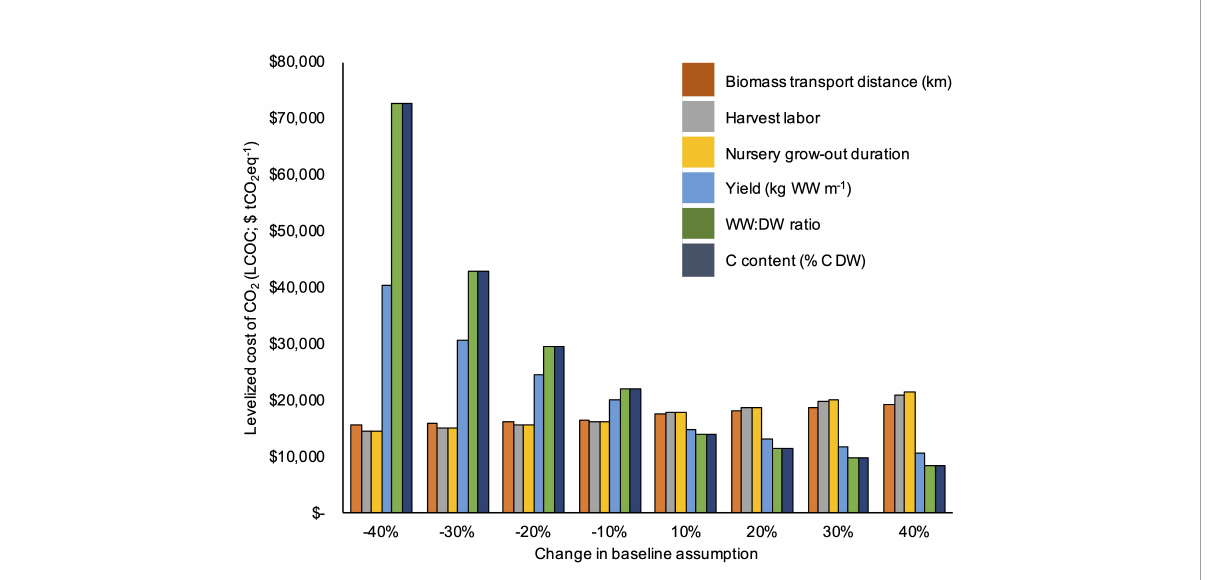
FIGURE 6 Results of a sensitivity analysis in which the required biomass transport distance (km), harvest labor requirements (FTE hours per ton of harvested biomass), nursery grow-out duration (days), yield (kg m -1 ), kelp WW : DW ratio (% WW), and kelp C content (% DW) were all changed in 10% increments to a range of +/- 40%. Parameters were changed individually while holding all others constant so as to assess the relative importance of each